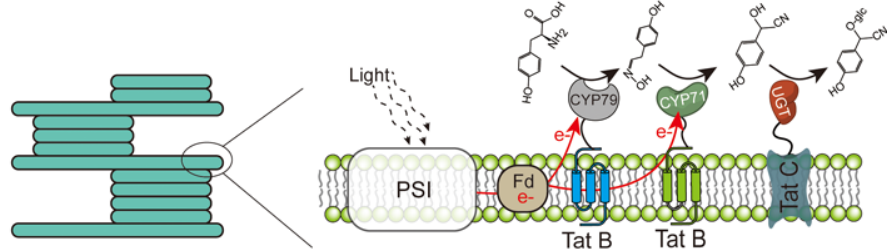
Figure 5. Schematic diagram of the Tat-scaffolded dhurrin pathway. Two P450s (CYP79A1, CYP71E1) and a soluble UDP-glucosyl transferase (UGT85B1) are anchored in the thylakoid membrane by exchanging the membrane anchors with the components of the self-assembled Tat B and Tat C.